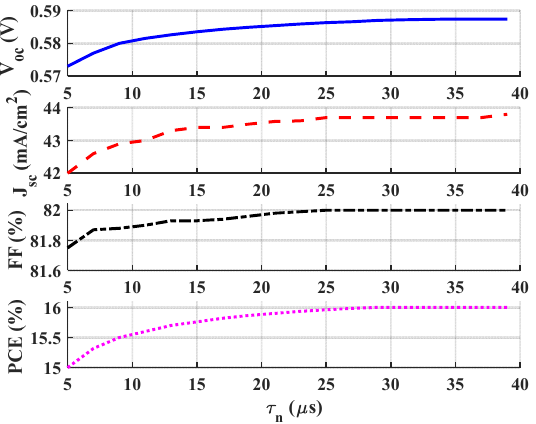
Figure 7. Photovoltaic parameters variation vs. base lifetime.